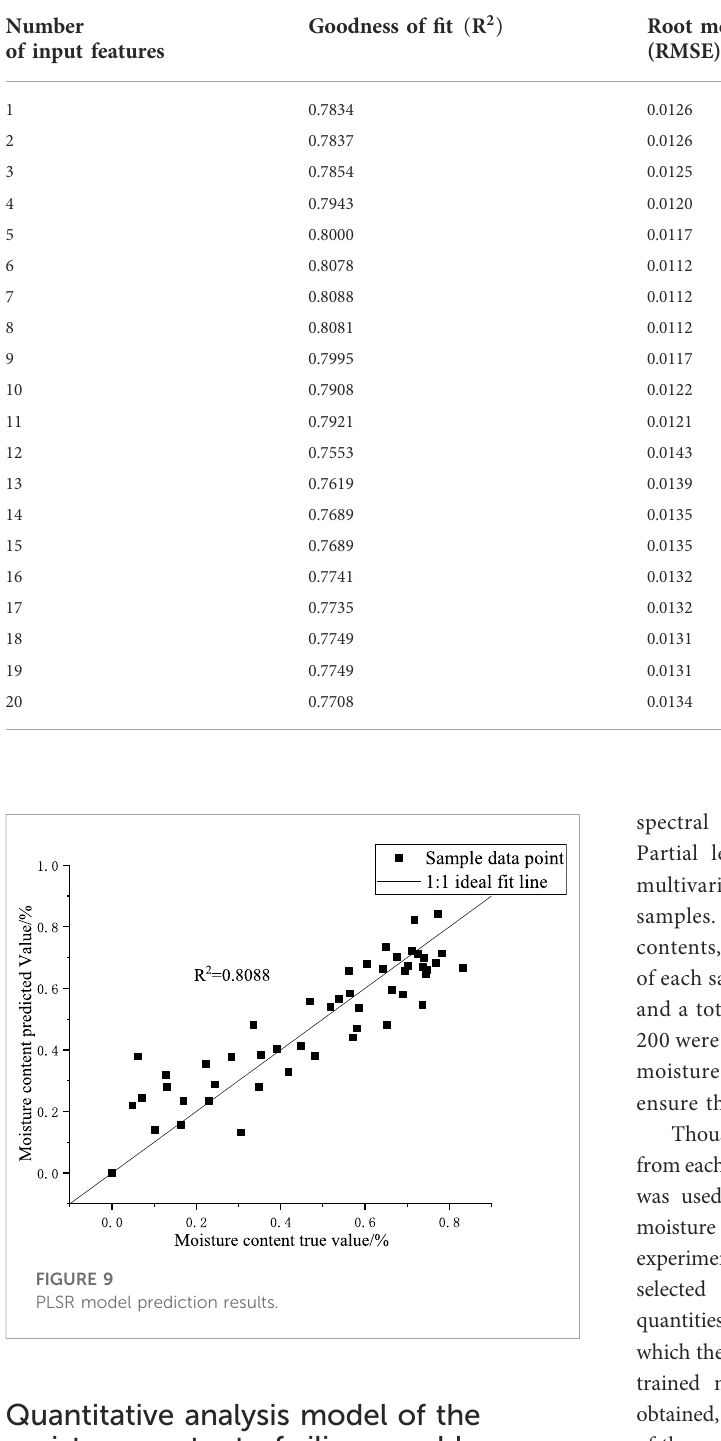
TABLE 1 Optimization of feature number for the PLSR model.